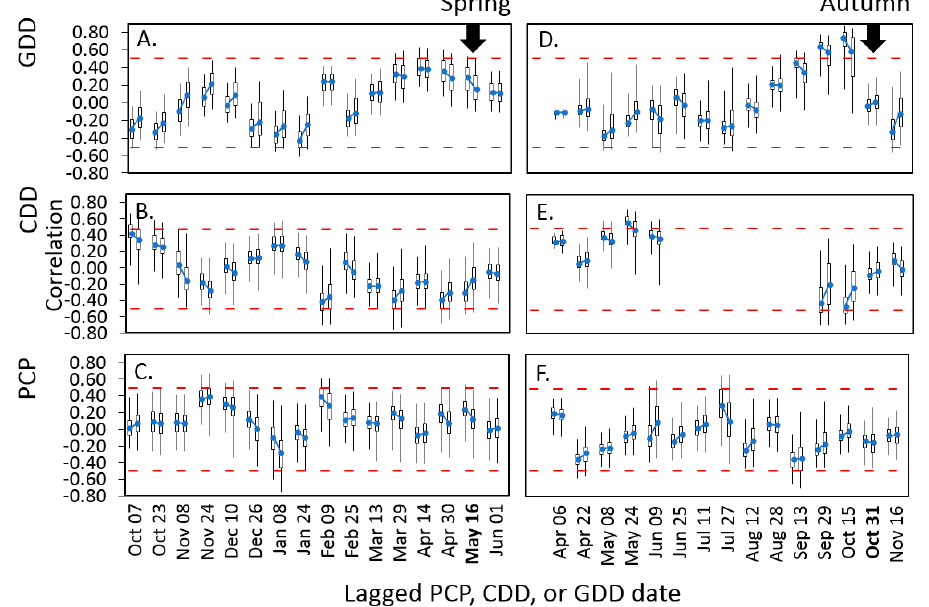
Figure 6. Distribution of 24-day time-lagged correlations of growing degree days (GDD; ( A , D )), chilling degree days (CDD; ( B , E )) and precipitation (PCP; ( C , F )) with spring ( A – C ) and autumn ( D – F ) NDVI across the Park, 2000–2015. Arrows represent the fixed spring (16 May) and autumn NDVI (31 October) periods being correlated with antecedent weather that goes backward in time to the left. Two correlation box plots are shown for each date with medians that are connected by a blue line wherein the left member shows pure hardwood forests ( N = 17,456 MODIS cells) and the right shows conifer and mixed forests ( N = 15,876 MODIS cells). Box plots show the 99th, 75th, 50th, 25th and 1st percentiles for each date-cover type combination. For general guidance, dashed red lines show critical values for 95% confidence intervals with 15 degrees of freedom (years).